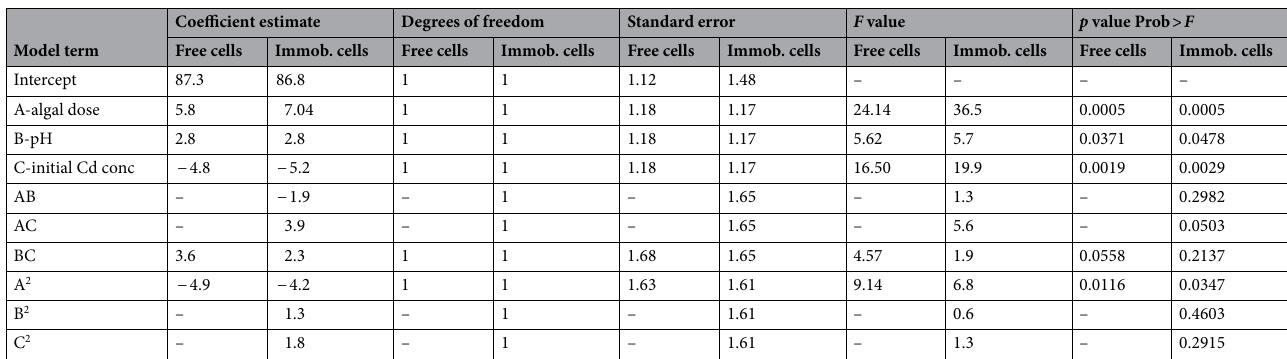
Table 1. Results of ANOVA for the quadratic model coefficients of Cd 2+ ions